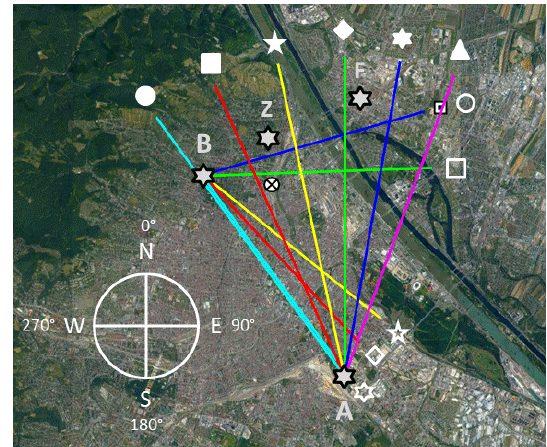
Figure 1. Geographical location of co-located instruments con- sidered in this study: Arsenal (A) and BOKU (B) MAX-DOAS with their associated azimuthal viewing directions (in the clock- wise direction): 324 ◦ (cyan), 336 ◦ (red), 348 ◦ (yellow), 0 ◦ (green), 10 ◦ (blue), and 20 ◦ (magenta) (Arsenal MAX-DOAS) as well as 74 ◦ (blue), 88 ◦ (green), 129 ◦ (yellow), 137 ◦ (red), and 144 ◦ (cyan) (BOKU MAX-DOAS). The white symbols at the end of azimuthal viewing directions are shown to better interpret the re- sults of Figs. 12 and 13. Ceilometer (Z), sun photometer (B), and in situ (F) instruments are located close to the 74 ◦ azimuthal view- ing direction of BOKU MAX-DOAS. The linear distance between the two MAX-DOAS instruments is ∼ 7 . 5km. The cross-in-circle symbol indicates the location of the waste incineration plant. Image ©Google